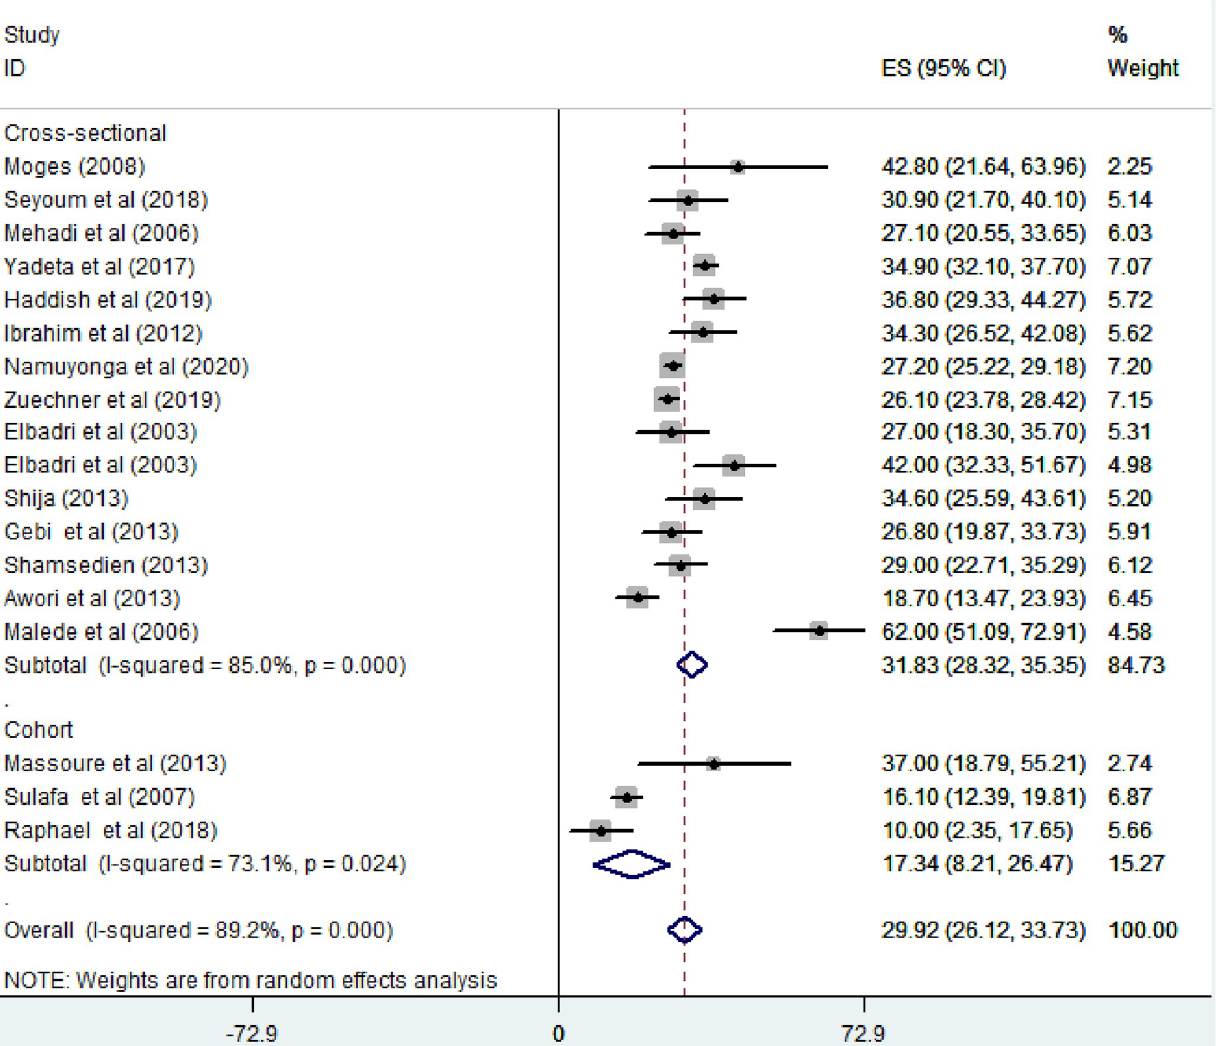
Fig 4. Forest plot showing subgroup analysis of the pooled magnitude of ventricular septal defect among congenital heart defect patients by study design in East Africa, from January 2000-October